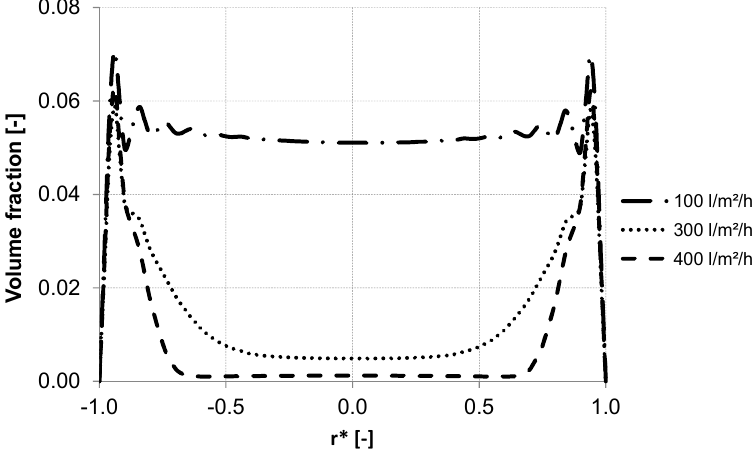
Figure 16. Particle distribution along control line C with various backwashing fluxes after 8 s (homogeneous initial distribution, particle diameter of 10 µm).